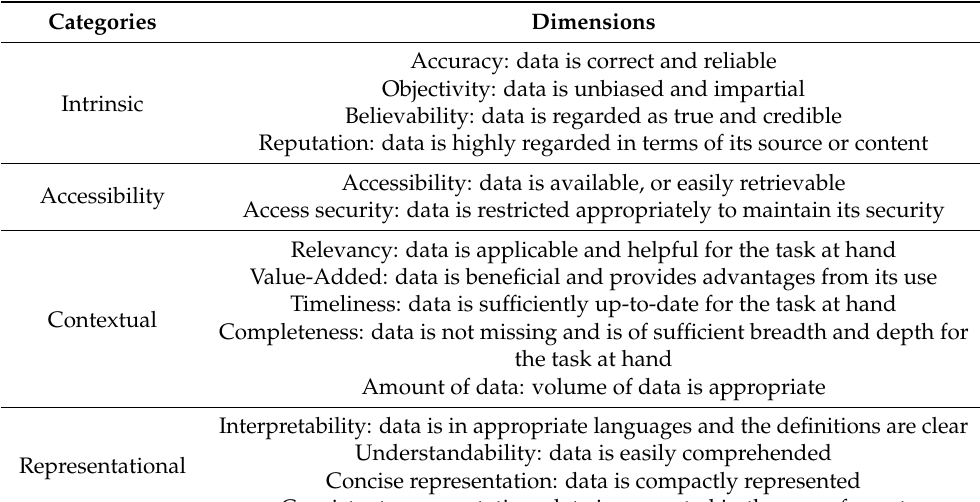
Table 1. Categories and dimensions of quality information